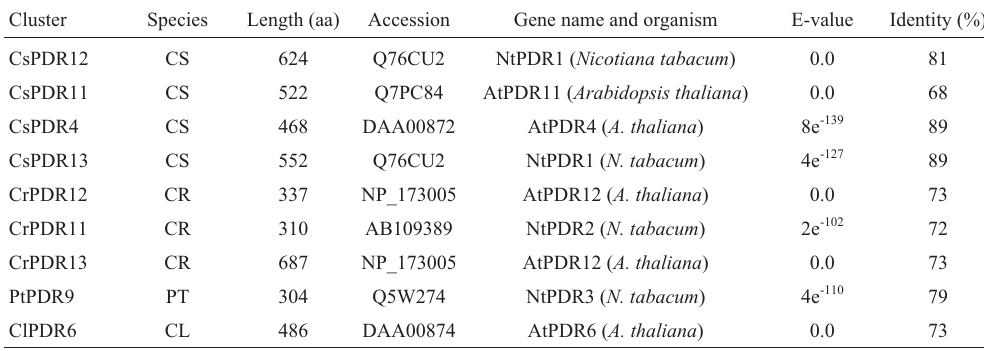
Table 1 - Pleiotropic drug resistance (PDR) transporters found in the CitEST